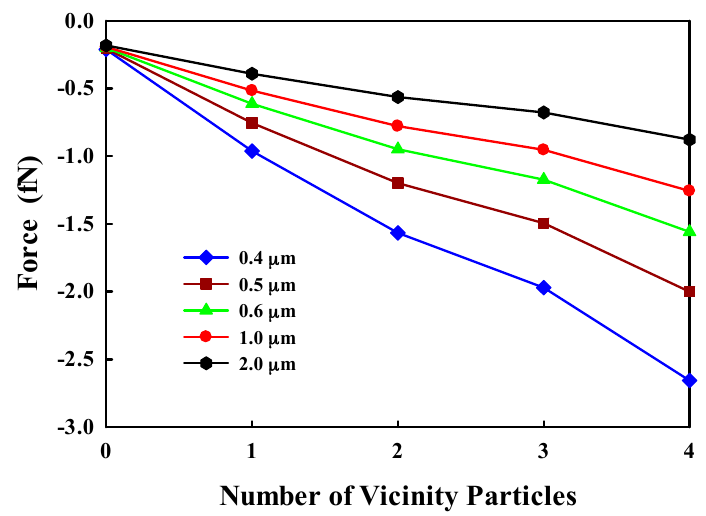
Figure 13. The attractive force on an 8- μ m suspending microparticle from the wall and deposited particles at the various distances.